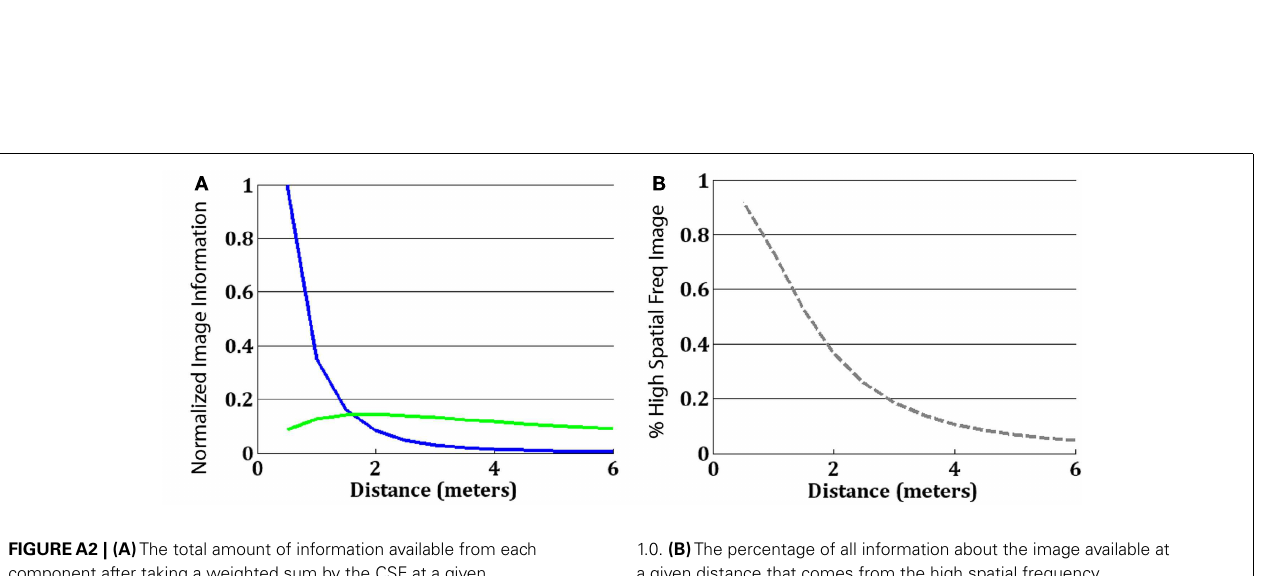
FIGUREA1 | (A) The information contained in a hybrid image is a mixture of the information originating from the high spatial frequency component of an image (blue) and the low spatial frequency component of another image (green). (B) From a distance of 3m, the information visible to human observers (the information available from a standard CSF, depicted